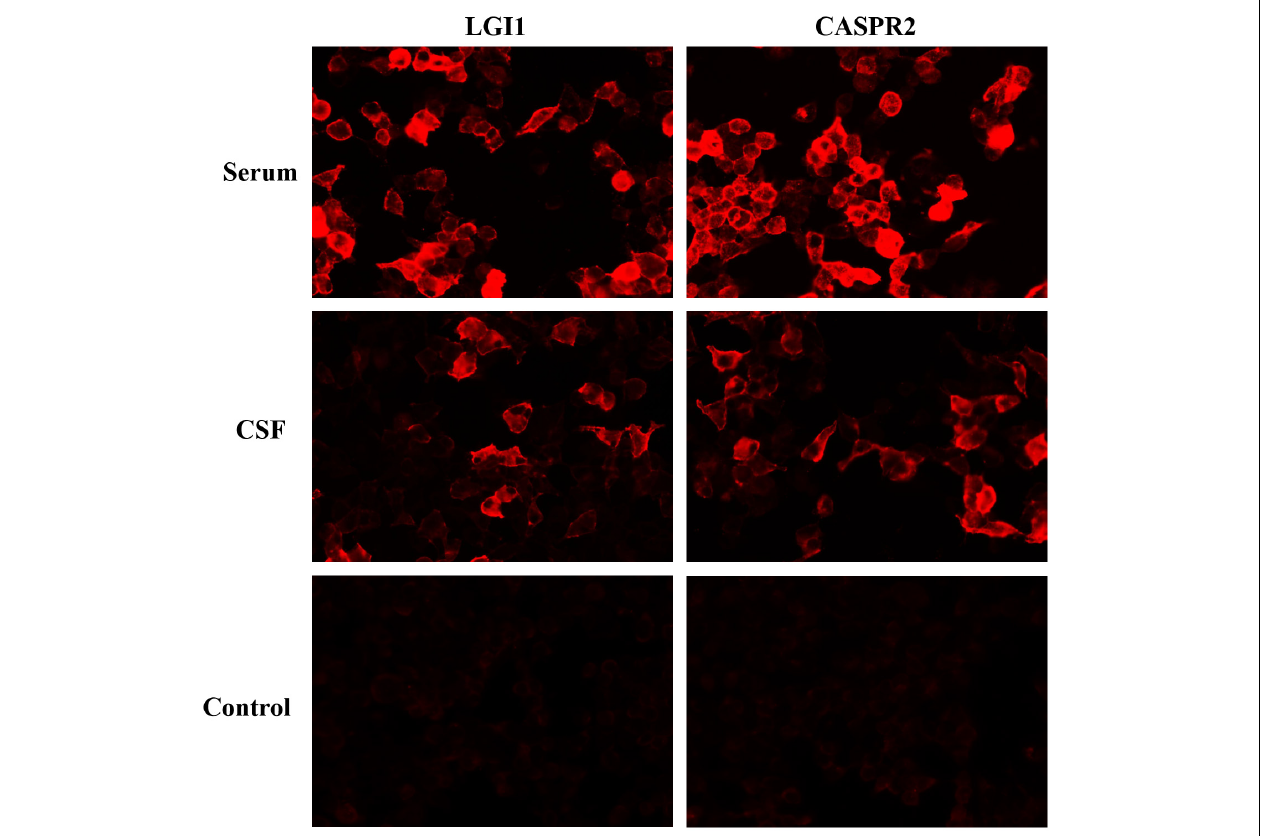
FIGURE 1 | Positive reaction with transfected HEK293 cells expressing LGI1 and CASPR2 after incubation with serum and cerebrospinal fluid of patient 1 followed by anti-immunoglobulin secondary antibody.